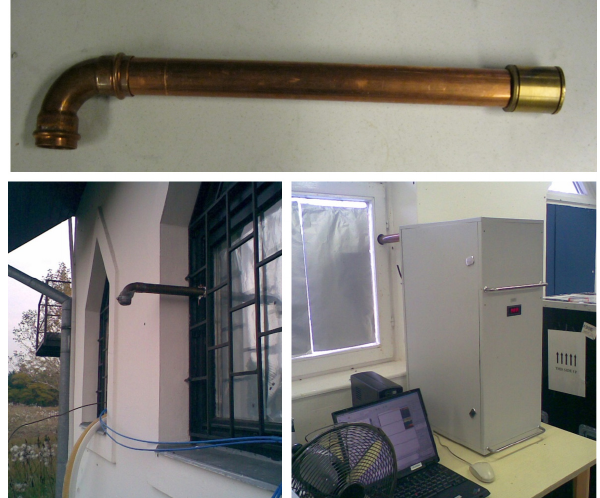
Figure 7. Example an aerosol sampling inlet for the NAIS used at K-puszta field station, Hungary. A grid is missing in the top image from the end of the sampling line. Below an instrument set-up on